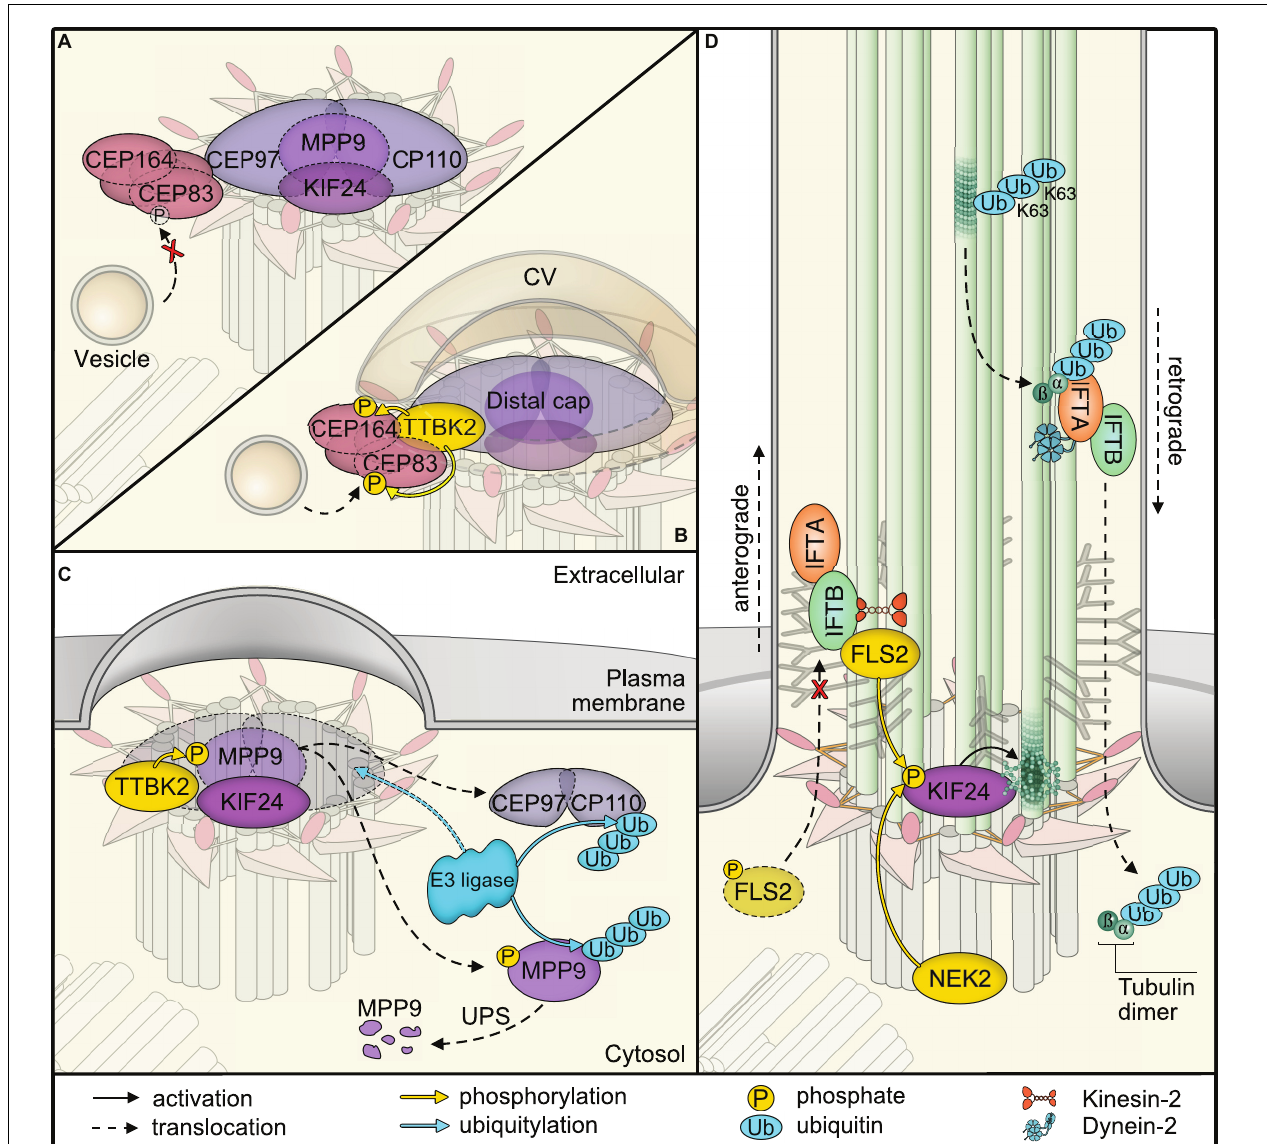
FIGURE 2 | Post-translational modifications (PTMs) in primary cilia assembly and disassembly. (A) Mother centriolar distal appendage components CEP164 and CEP83 are shown in red. The distal end proteins KIF24 and MPP9 recruit the capping protein complex CEP97–CP110 to block axoneme extension. Note that only one cap is shown for simplicity, while each microtubule triplet is capped by one complex. Unphosphorylated CEP83 diminishes ciliary vesicle recruitment (B) CEP164 recruits the kinase TTBK2 that phosphorylates CEP164 and CEP83. Recruitment and activity of TTBK2 enables subsequent steps of cilia assembly such as formation of the ciliary vesicle (CV). (C) TTBK2 phosphorylates MPP9, which results in ubiquitylation and dissociation of MPP9 and the remaining CEP97–CP110 complex from the distal centriolar end. Several E3 ubiquitin ligase complexes have been implicated in modifying distal cap components, while the precise location of ubiquitylation has not been determined (see text for details). Ultimately, MPP9, CEP97, and CP110 are degraded by the proteasome (UPS) and ciliary growth can be initiated. (D) Diagram of fully assembled primary cilium. The microtubule depolymerizing kinesin KIF24 has been implicated in microtubule disassembly. Phosphorylation of KIF24 by NEK2 stimulates KIF24 activity. In Chlamydomonas , dephosphorylated FLS2 enters cilia by binding to IFT-B and phosphorylates the KIF24 homolog. Upon disassembly, tubulins are ubiquitylated by unknown mechanisms. IFT-A binds to K63-linked ubiquitin chains and mediates